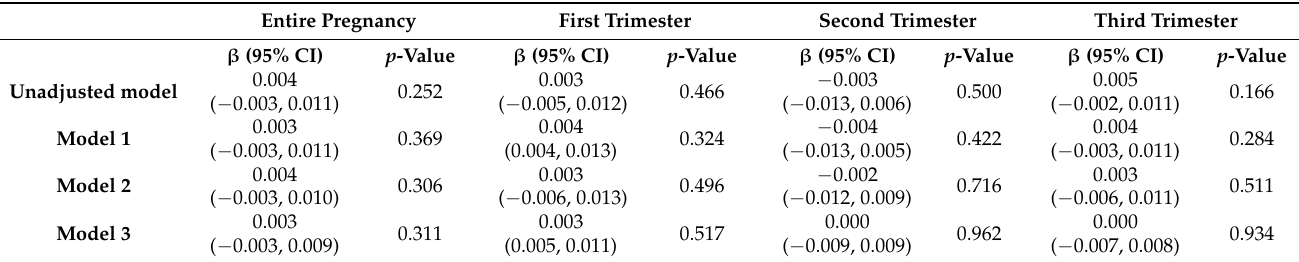
Table 6. Maternal serum 25-OHD concentration during the first, second, and third trimester and entire pregnancy and average relative TL of the